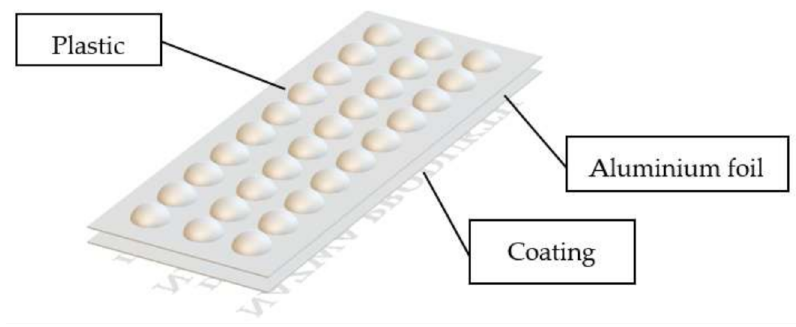
Figure 1. Blister pack and its